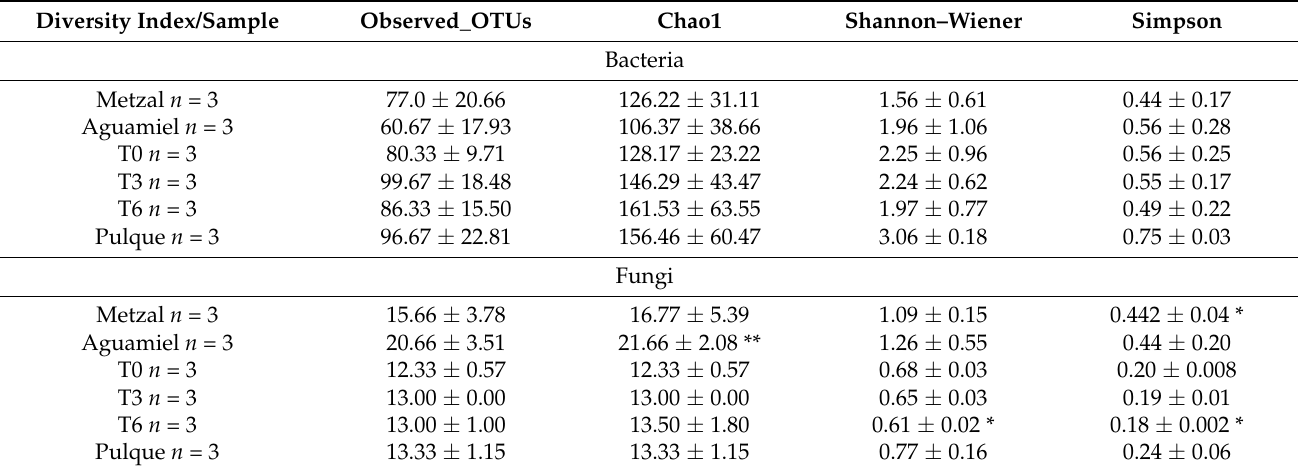
Table 2. Alpha diversity